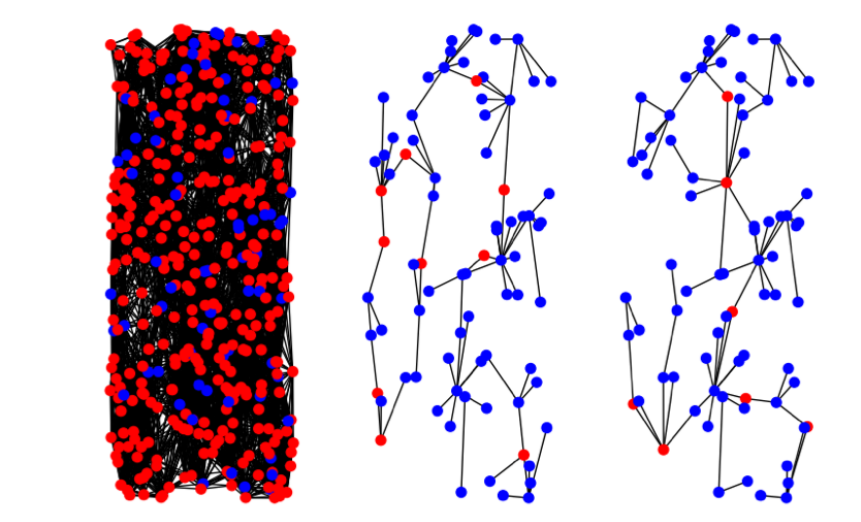
Figure 8. Example of valid random solutions. The left side of the figure shows an example red–blue visibility graph, whereas two different valid solutions are depicted to its